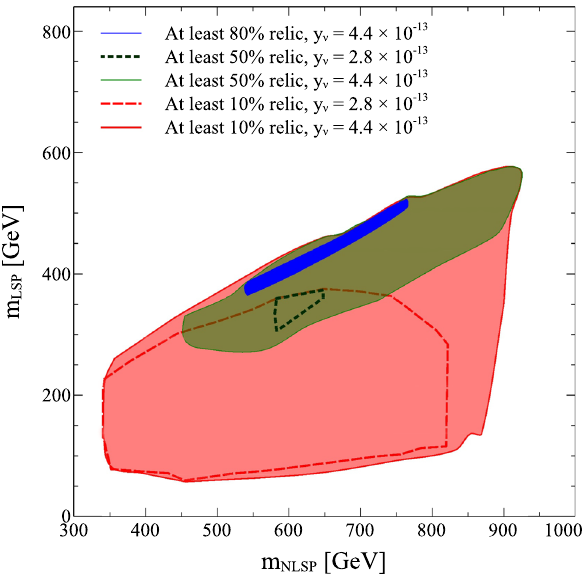
Fig. 9 Allowedparameterrangewithpercentagerelicabundanceinthe ( m − m ) space for two different Yukawa couplings m ˜ τ − m ˜ ν NLSP LSP R corresponding to the degenerate and ‘hierarchical’ neutrino masses